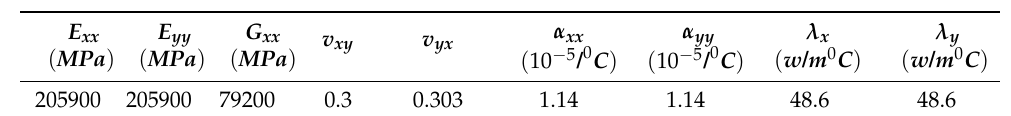
Table 2. Constants of